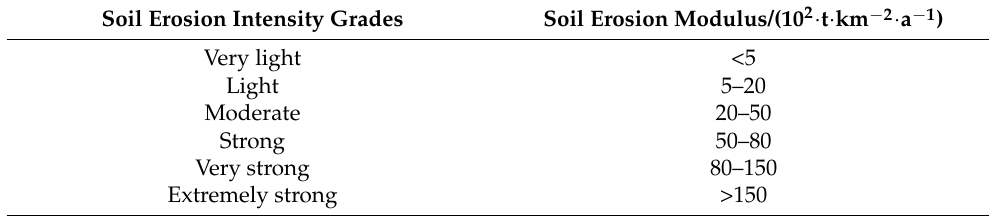
Table 2. Soil erosion grading standard [46]. Soil Erosion Intensity